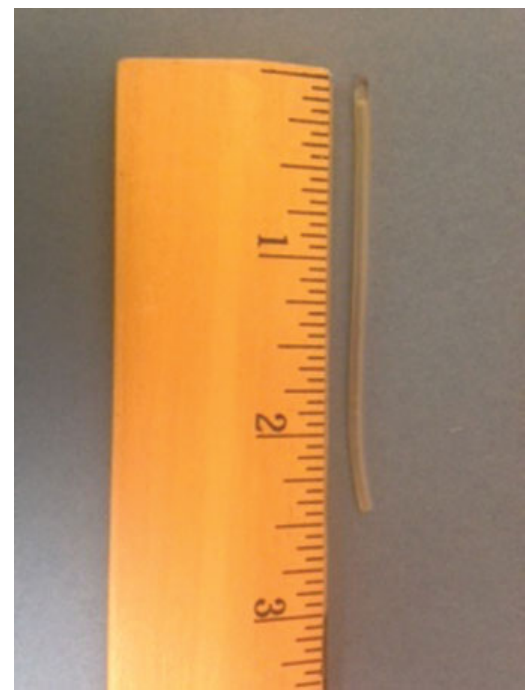
Fig. 3 Removed suction